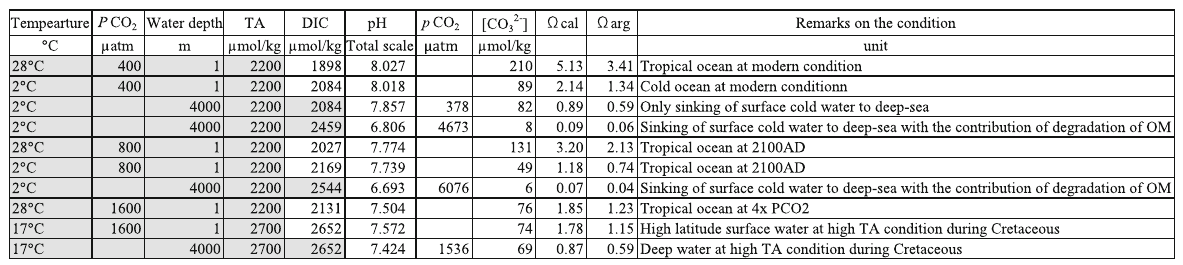
Table 1 Water properties under different environmental conditions. In particular, [CO 32 − ] and the corresponding saturation states of calcite and aragonite ( Ω cal and Ω arag ) are calculated for modern, 2110 AD, and Cretaceous conditions using CO2calc (Robbins et al. 2010). The numbers in the gray color column show the initial settings for the calculation